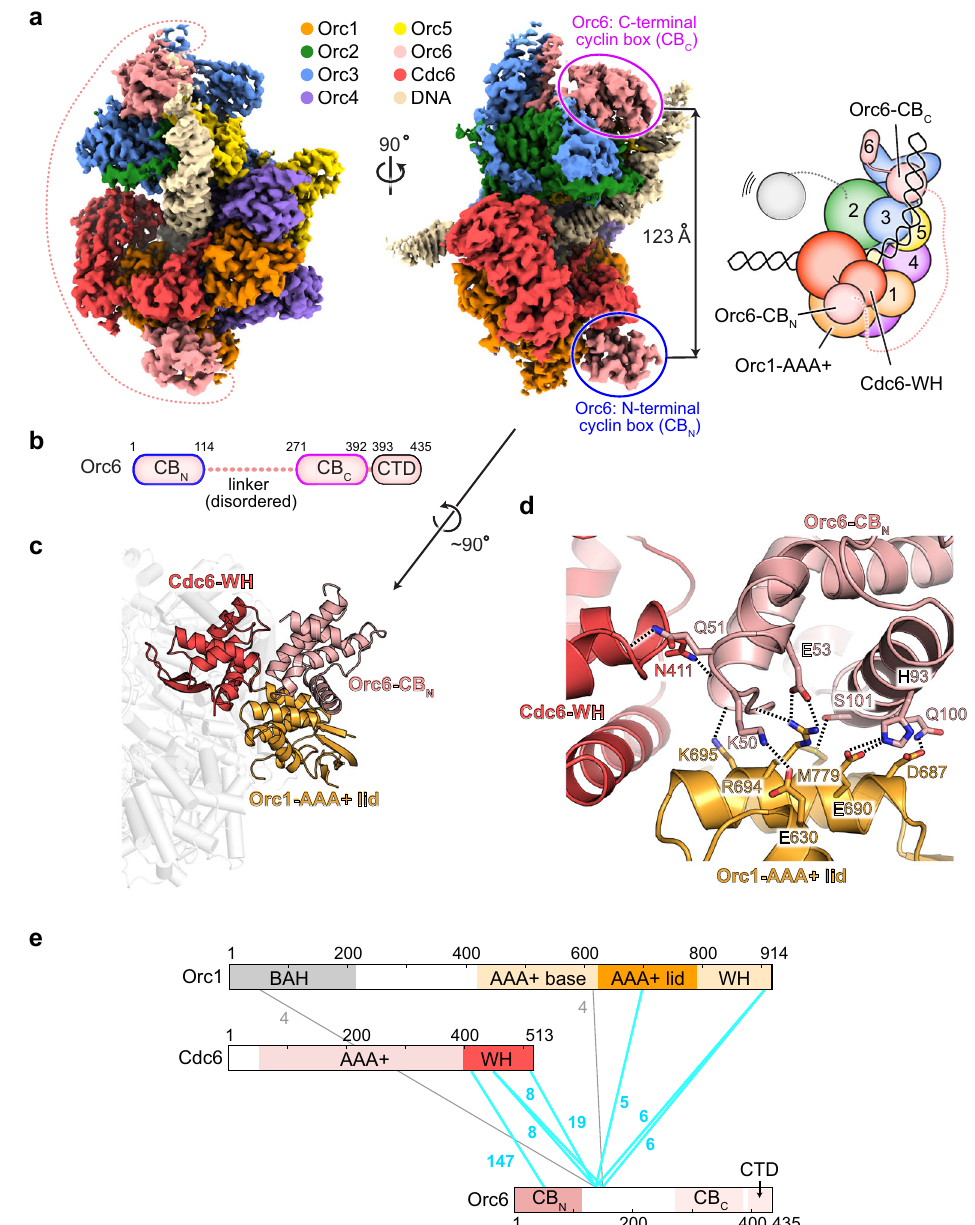
Fig. 3 The N-terminal domain of Orc6 docks onto the ORC·Cdc6 ring through interactions with Orc1 and Cdc6. a Unsharpened cryo-EM map and schematic of Sc ORC·DNA·Cdc6 with a docked N-terminal cyclin box domain (CB N ) of Orc6. The fl exible linker between N- and C-terminal CB folds is indicated by a dashed line. b Scheme of Sc Orc6 ’ s domain architecture. CB N and CB C share structural similarity with transcription factor TFIIB, which is predicated on cyclin box folds. c and d Orc6-CB N directly docks onto the Cdc6 WH domain and the lid subdomain of the Orc1 AAA + fold. Interacting domains are rendered as colored cartoon in ( c ). A zoomed view of the binding site is shown in ( d ) with interacting side chain residues rendered as sticks and hydrogen bonds and salt bridges displayed by dashed lines. e Crosslinks between Orc1, Cdc6, and Orc6 identi fi ed by mass spectrometry. Cyan lines highlight crosslinks involving Orc6-CB N or the proximal linker region immediately following this domain. The number of crosslink-spectra matches (CSM) is listed for each crosslink. See Supplementary Fig. 8c for a summary of observed crosslinks between all subunits in Sc ORC·DNA·Cdc6. CB – cyclin box domain, CTD – C-terminal domain, WH – winged-helix domain, BAH – bromo-adjacent homology